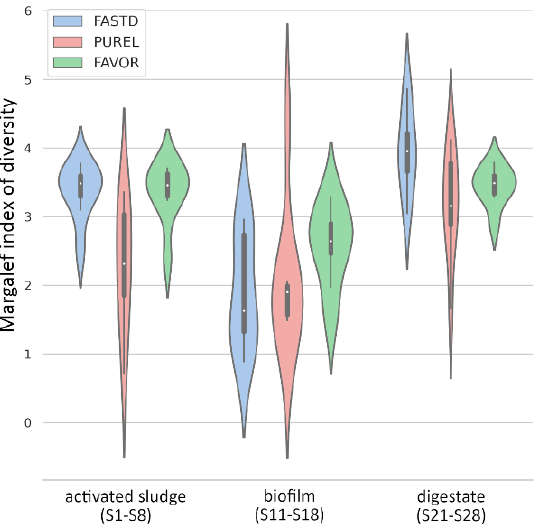
Figure 2. The comparison of values of the Margalef index of diversity calculated on the base of ARISA peaks. DNA was extracted from samples of activated sludge (S1–S8), biofilm (S11–S18), and digestate from a digestate chamber (S21–S28) using three kits: FASTD, PUREL, and FAVOR.